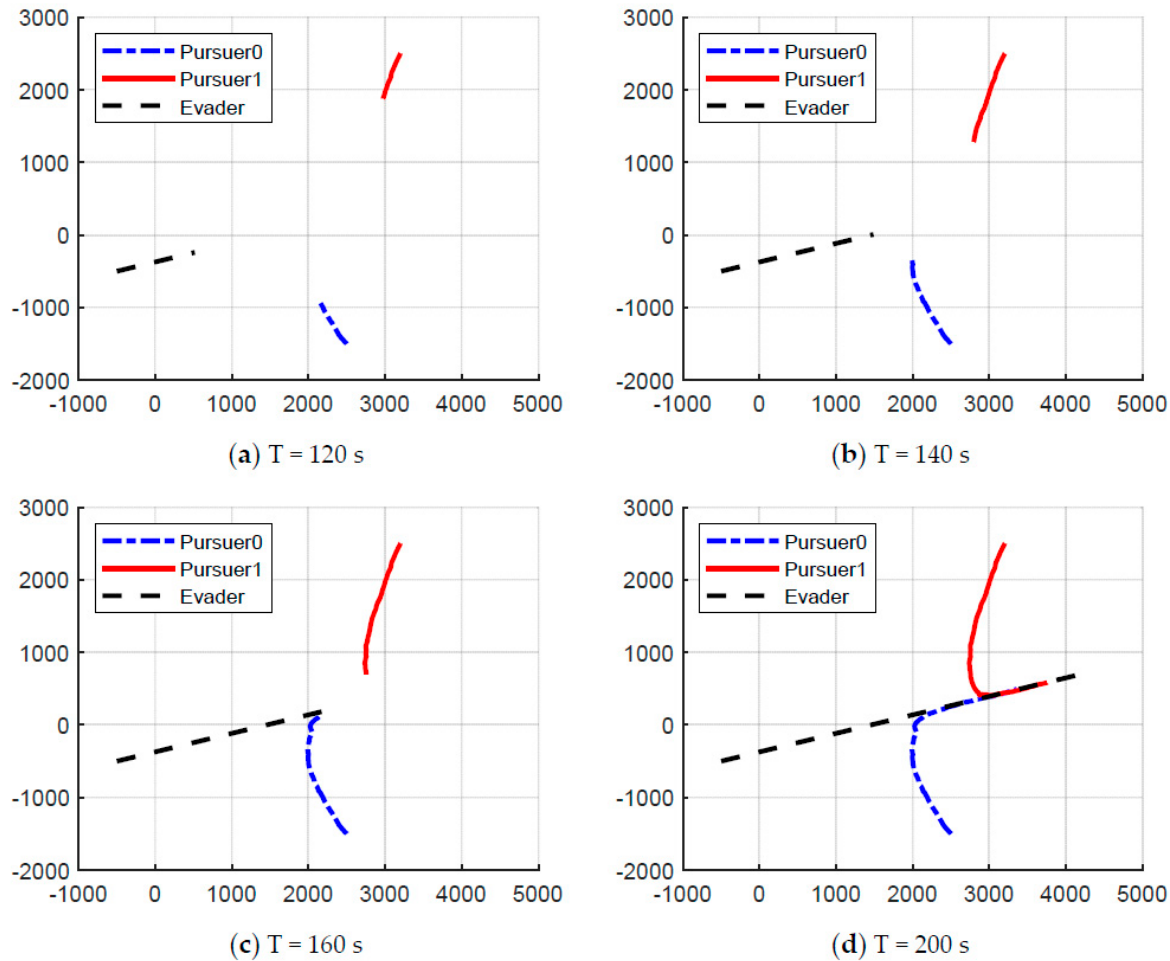
Figure 10. The traces of P 0 , P 1 and E 0 based on Apollonius circles with an estimated speed error ∆ v = 30% v P